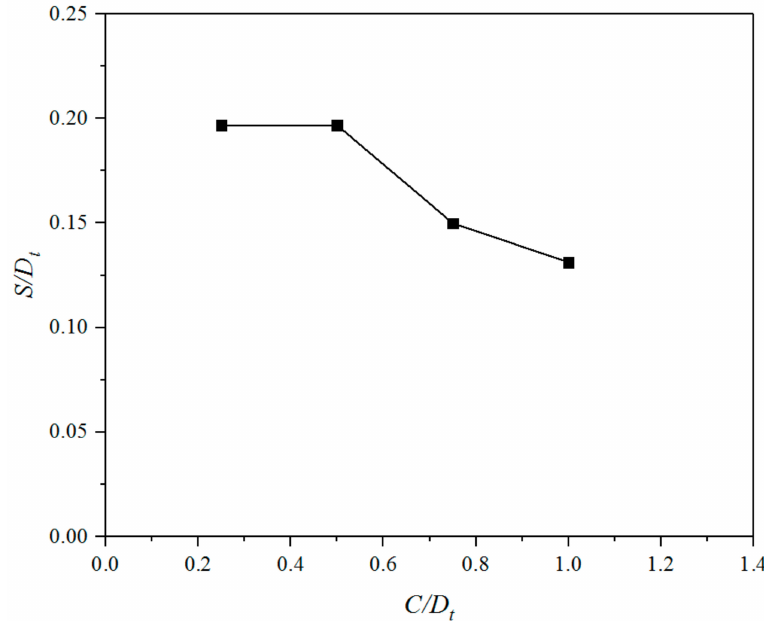
Figure 14. Seabed scour depth at di ff erent tip clearances.